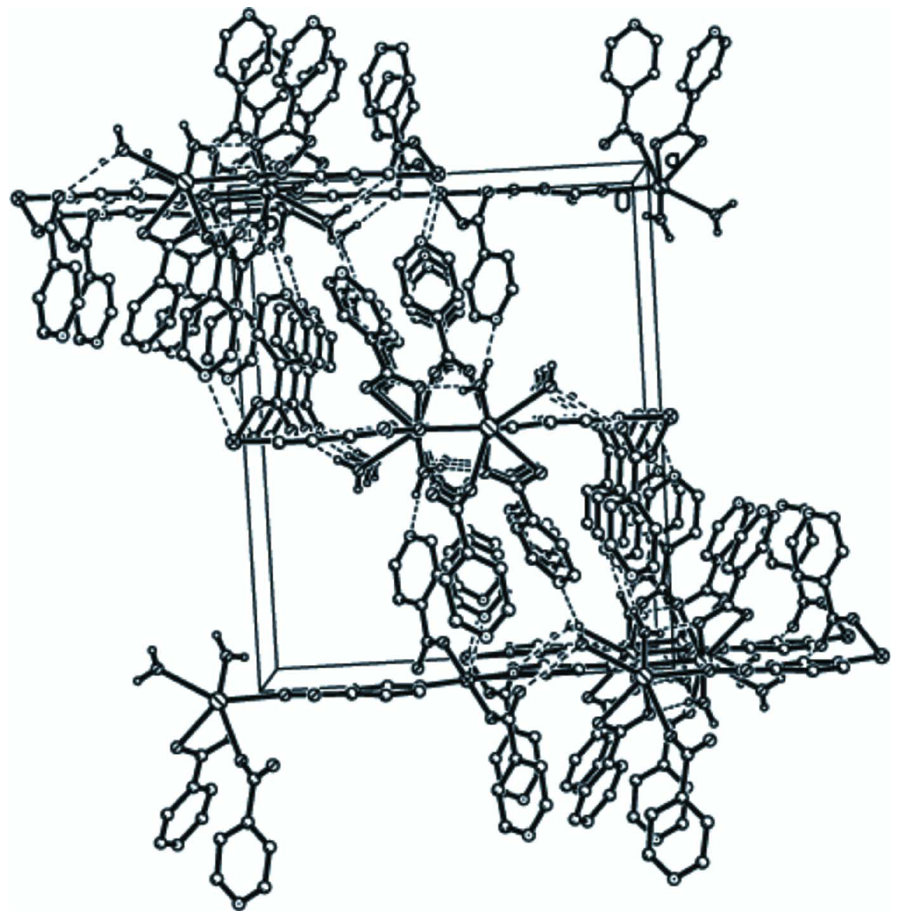
Projection showing the three-dimensional structure formed by H-bonding interaction of the compound (I). catena-poly[{di- µ -isonicotinato-bis[diaquaisonicotinatoeuropium(III)]}- µ - isonicotinato-[diisonicotinatocopper(II)]- µ -isonicotinato] Crystal